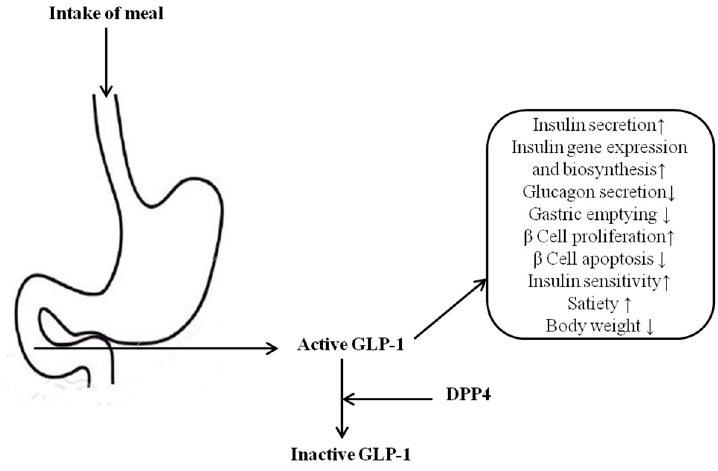
Figure 1. Glucagon-like peptide 1 (GLP-1) activation effects by meal intake, and its metabolism through dipeptidyl peptidase-4 (DPP-4) [6].